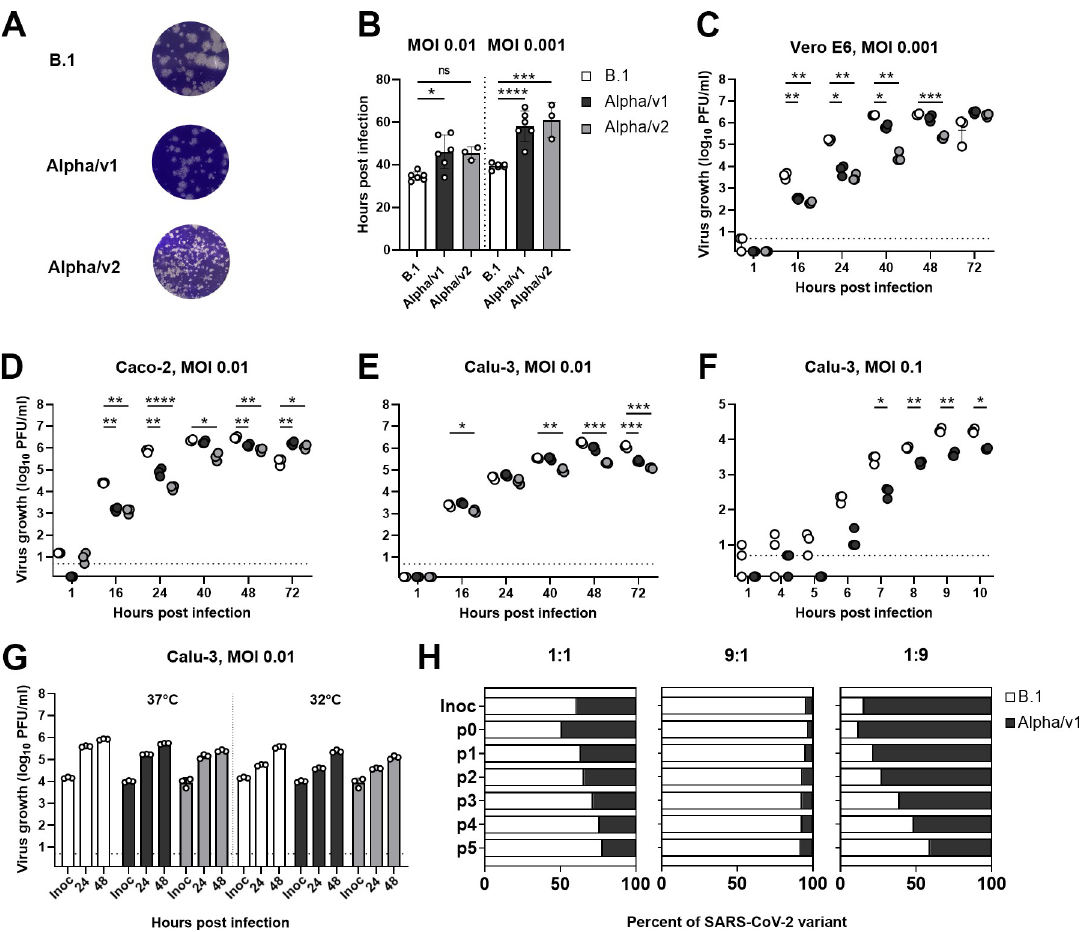
Fig 1. Compared to SARS-CoV-2 B.1, VOC Alpha shows similar or inferior replication kinetics in immortalized cell lines. ( A ) Plaque morphology on Vero E6 cells, which were infected with 1:100 diluted (B.1 and VOC Alpha/v1) or undiluted (VOC Alpha/v2) supernatants of infected Vero E6 cells. ( B ) Vero E6 cells were infected at the indicated MOI and onset of CPE was monitored by live cell imaging until 70 hours postinfection. ( C - E ) Virus growth was quantified in Vero E6 ( C ), Caco-2 ( D ), and Calu-3 ( E ) cells infected at indicated MOIs. Supernatant collected at the respective time points was titrated by plaque assay. Growth kinetic experiments in Vero E6 and Caco-2 cells were each performed in triplicates. One representative experiment out of 2 is shown for Calu-3 cells. ( F ) Virus growth in Calu-3 cells infected at an MOI of 0.1 was quantified at early time points after infection. ( G ) Virus growth kinetics in Calu-3 cells at 37˚C (left) and 32˚C (right). ( H ) Competition assay. Calu-3 cells were infected with a mixture of B.1 and VOC Alpha/v1 at indicated ratios (B.1: VOC Alpha/v1 ratio of 1:1, 9:1, and 1:9) with a total infectious dose of 10,000 PFU (corresponding to an MOI of 0.04). After serial passaging, viral RNA from the supernatant was isolated, sequenced, and the relative proportion of B.1- and VOC Alpha- corresponding sequences (discriminated by a mutation in nsp12; see also S1 Fig) was plotted. Data show arithmetic means of 1 experiment performed in triplicates. Dashed horizontal lines indicate the lower detection limit of the plaque assay. CPE, cytopathogenic effect; Inoc., Inoculum; MOI, multiplicity of infection; PFU, plaque-forming units; p0-p5, passage 0–passage 5; SARS-CoV-2, Severe Acute Respiratory Syndrome Coronavirus 2; VOC, variant of concern. See S1